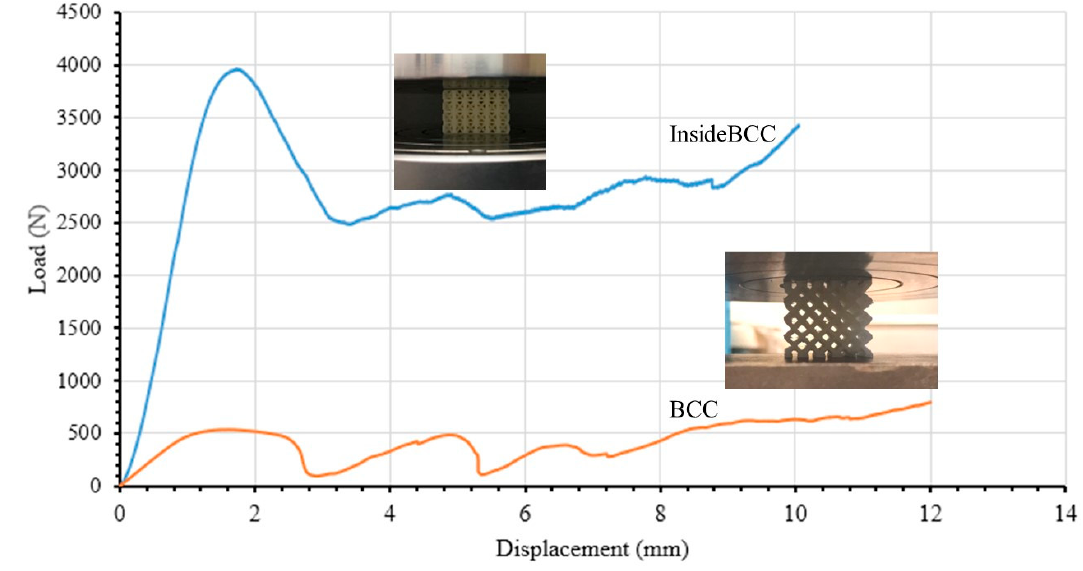
Figure 11. Comparison of load—displacement curves for BCC and InsideBCC configurations: BCC sample (brawn line) and InsideBCC sample (blue line).